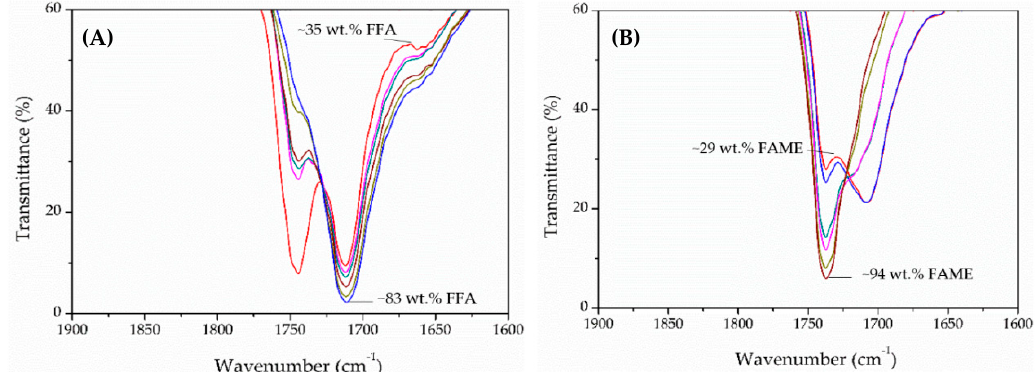
Figure 2. FTIR spectrum during soapstock acid oil hydroesterification. ( A ) Hydrolysis reaction (range of ~35–83 wt.% FFA); ( B ) esterification reaction (range of ~29–94 wt.% FAME). Table 1. Linear equations for monitoring hydroesterification (hydrolysis and esterification) of the acid oil from soapstock by